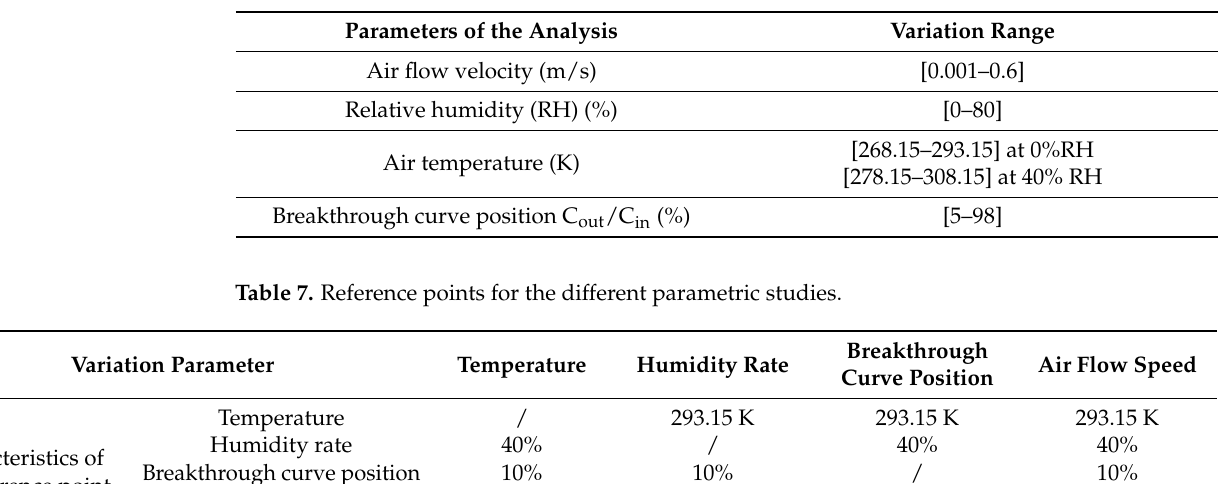
Table 6. Studied parameters and range of variation.